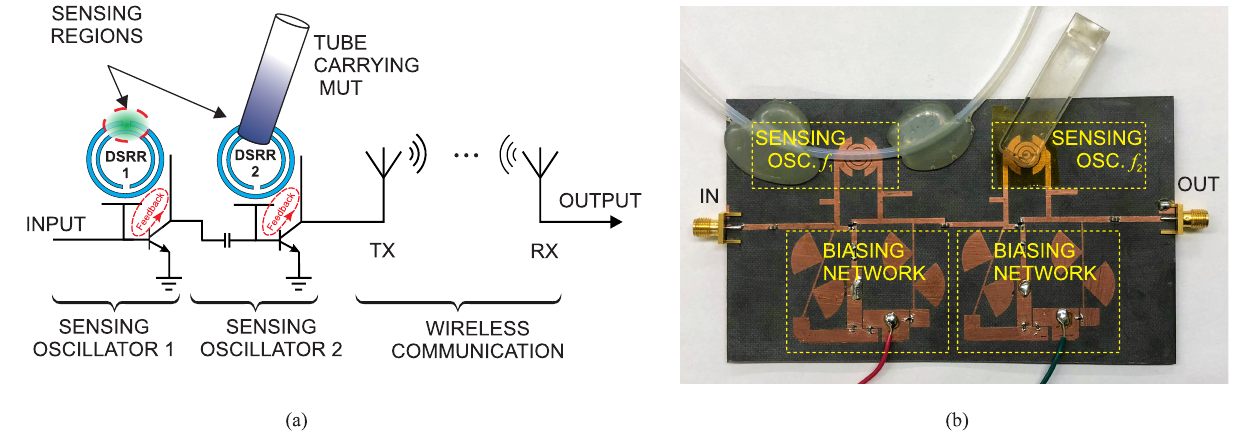
Figure 38. The schematic of t0he intermodulation-based microwave sensor. ( a ) Schematic of the intermodulation-based sensor and wireless communication. ( b ) Fabricated sensor. Reprinted with permission from Ref. [41].